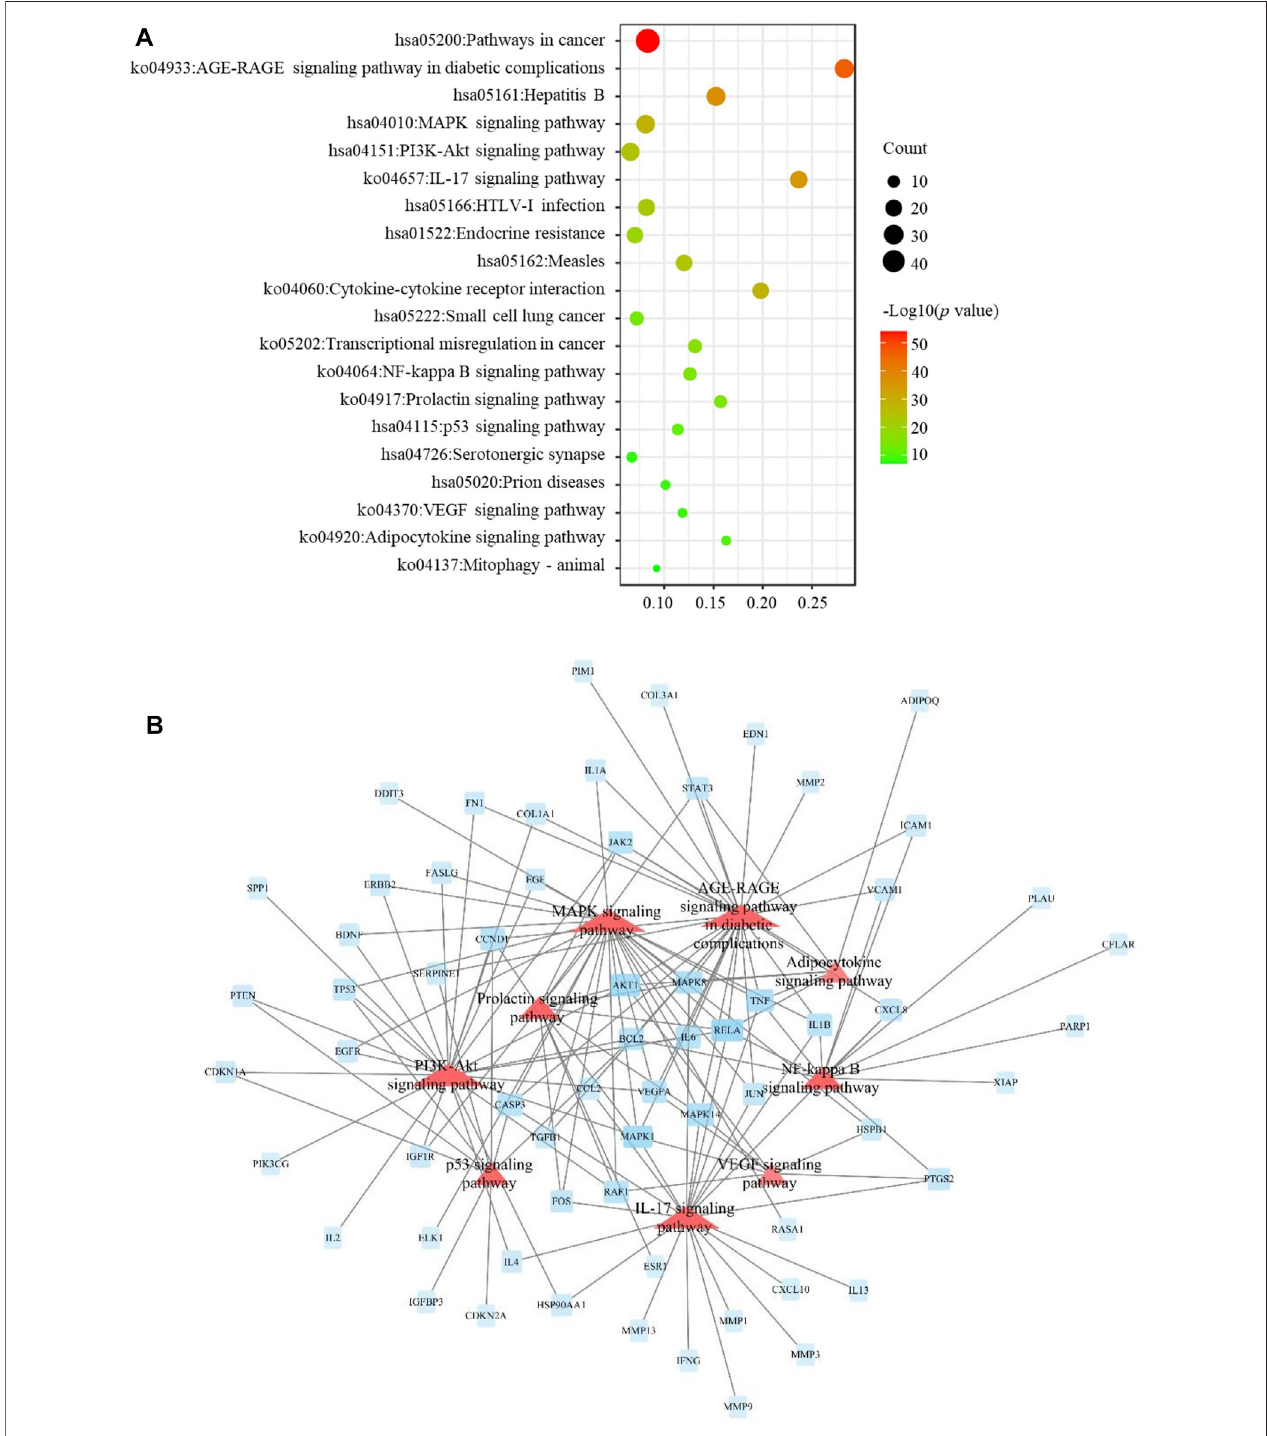
FIGURE 6 | KEGG pathway enrichment analysis. (A) Signaling pathways related to the JBOL treatment of IPF. (B) The key pathways related to IPF regulated by JBOL.